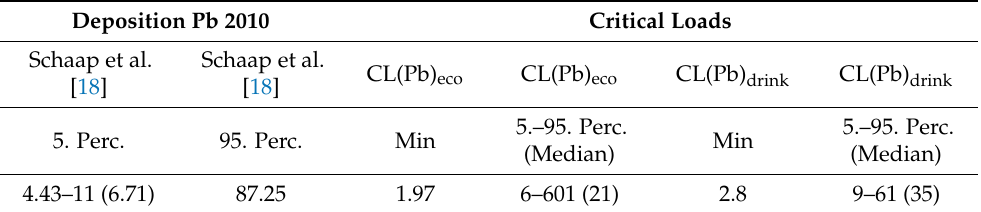
Table 8. Comparison of Pb deposition 2010 (in g ha − 1 a − 1 ) with the Critical Loads (in g ha − 1 a − 1 ) of receptor surfaces in